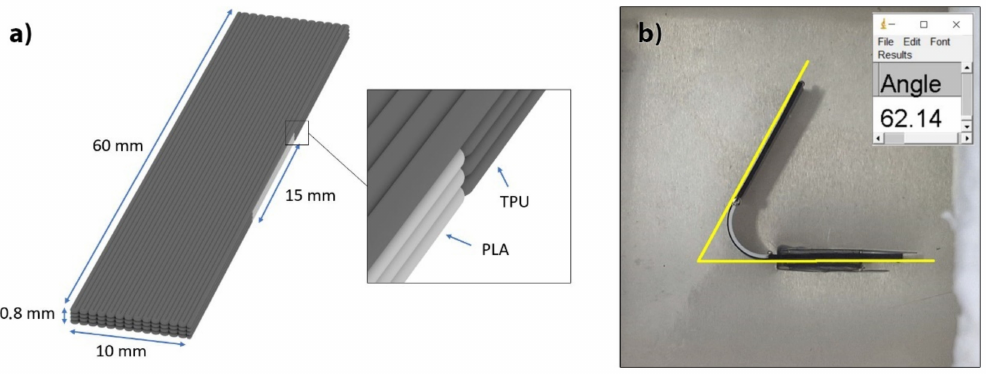
Figure 3. ( a ) Scheme of 3D printed test sample, ( b ) determination of extent (angle) of